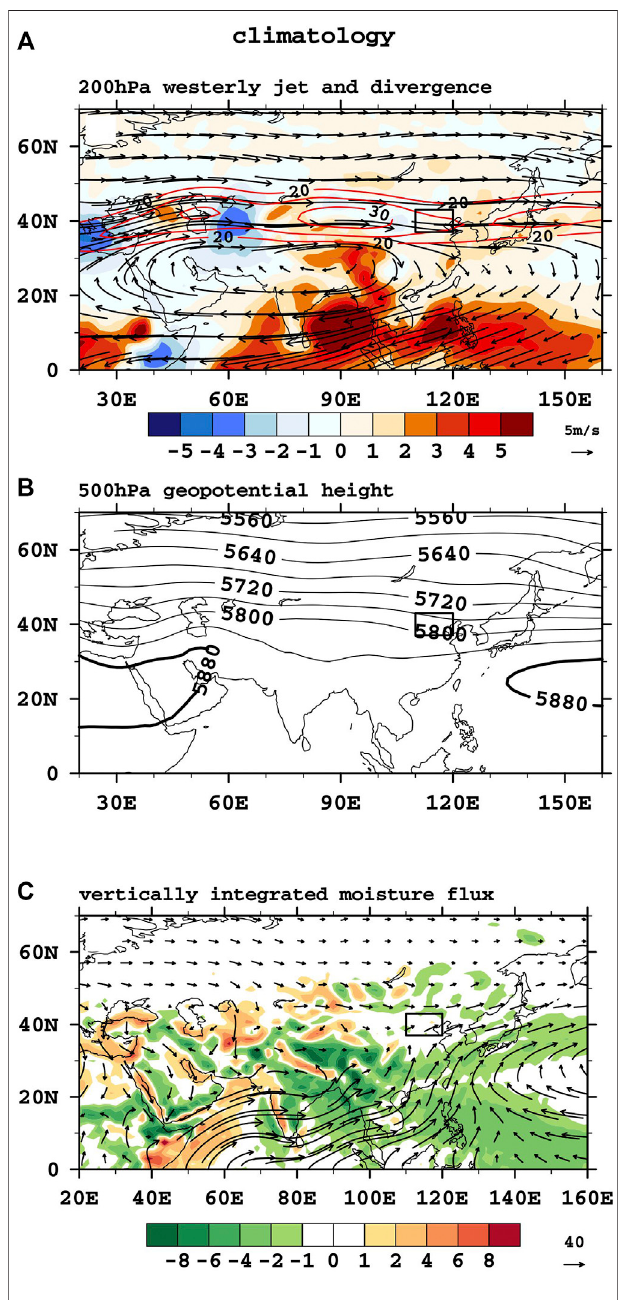
FIGURE 5 | Climatology of wind fi eld (vector, unit: m · s − 1 ), westerly jet (contour, unit: m · s − 1 ) and divergence (shading, unit: 10 − 6 s − 1 ) at 200 hPa (A) , geopotential height (contour, unit: gpm) at 500 hPa (B) , vertically integrated moisture fl ux (shading, unit: 10 − 5 kg/m 2 /s) and moisture fl ux divergence (vector, unit: kg/m/s) from 1,000 to 300 hPa (C) during summer from 1981 to 2010.